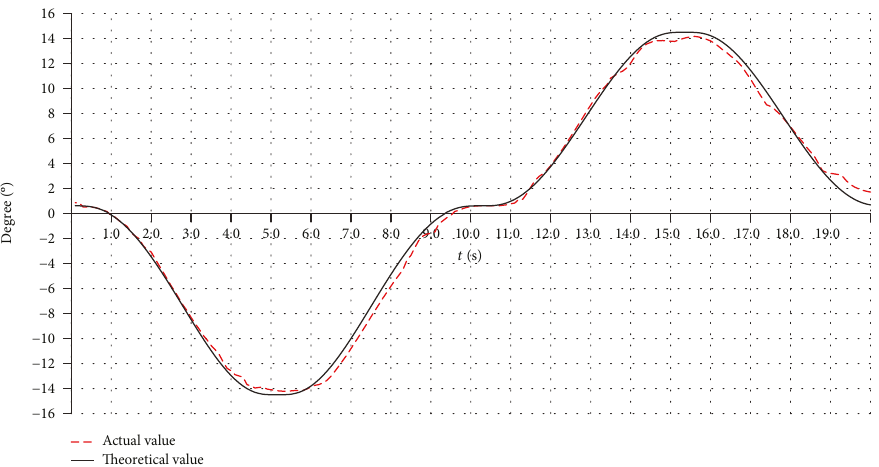
Figure 23: The working angles (from -15 ° to +15 ° ) for the varus/valgus rehabilitation